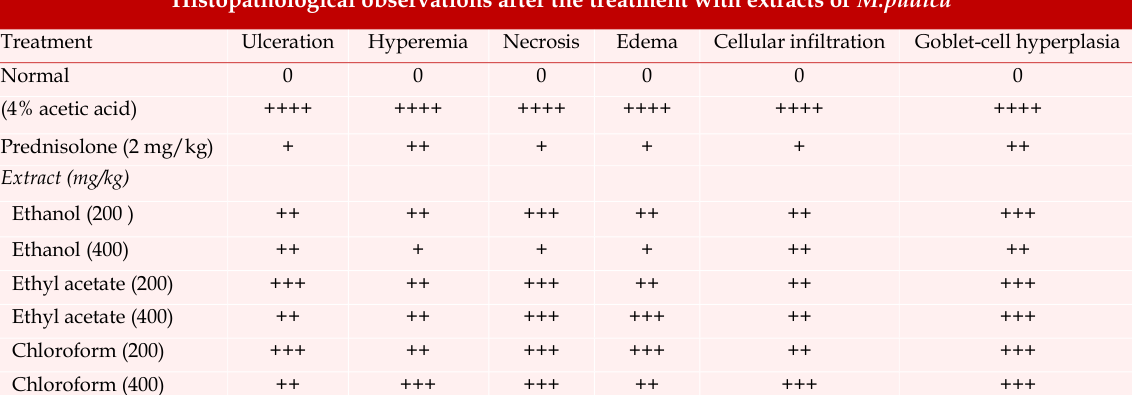
Histopathological observations after the treatment with extracts of